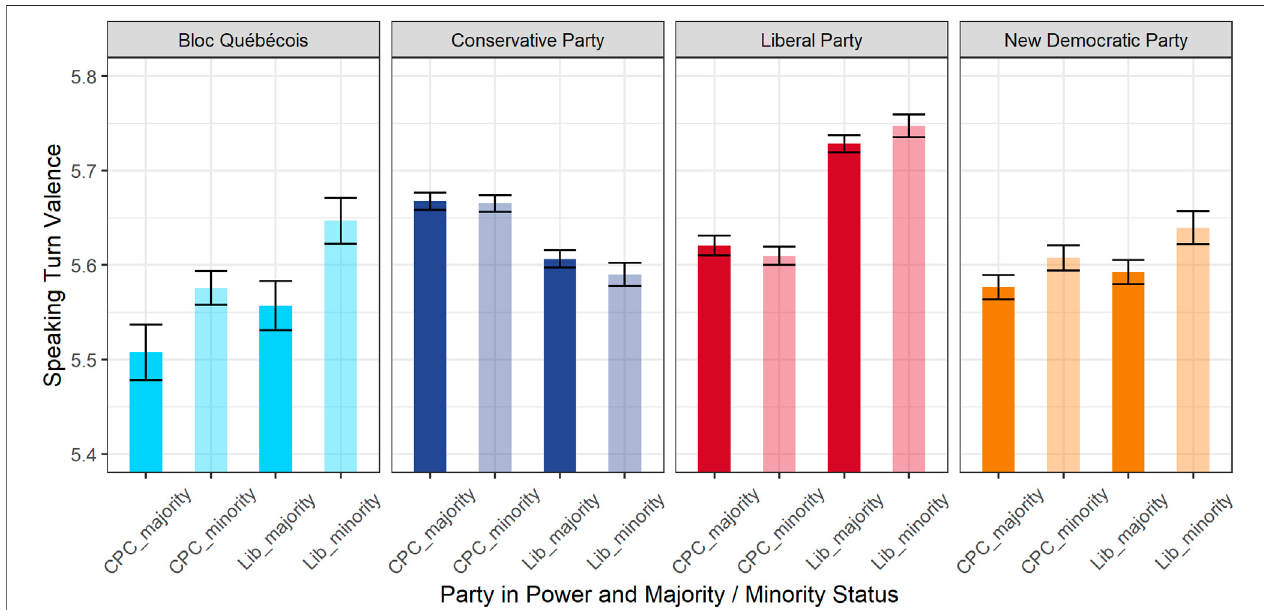
Frontiers in Communication |